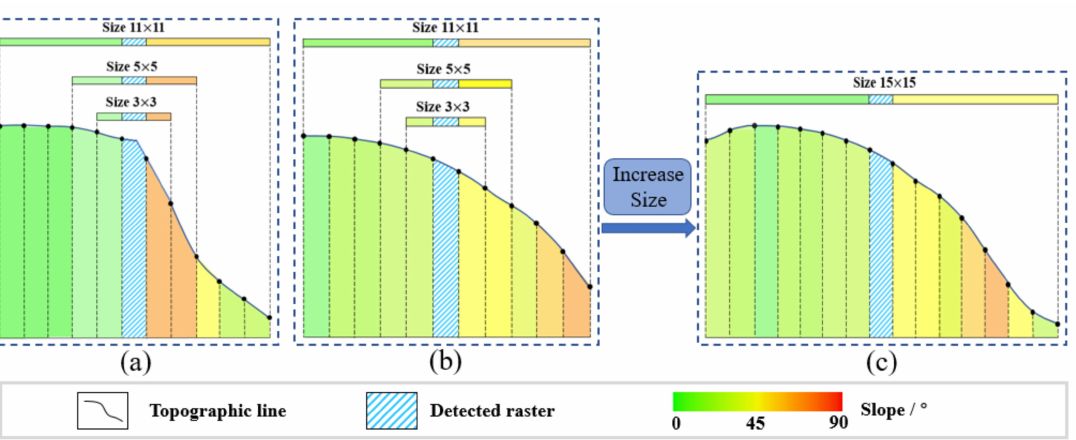
Figure 14. Influence of terrain factors on extraction: ( a ) areas with cliffs; ( b ) areas with gentle slopes; ( c ) areas with increasing size of the analysis